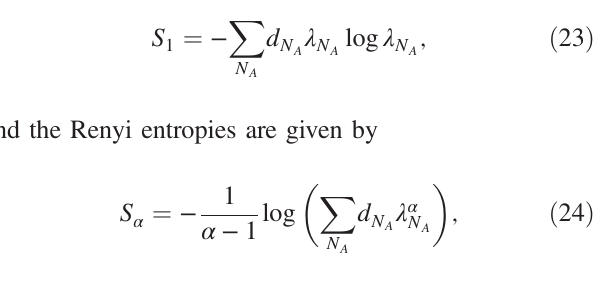
ψ i β ¼ 0 Þ , for the hardcore A ðj 4 , and filling N ¼ 6 . A ¼ of the sector A